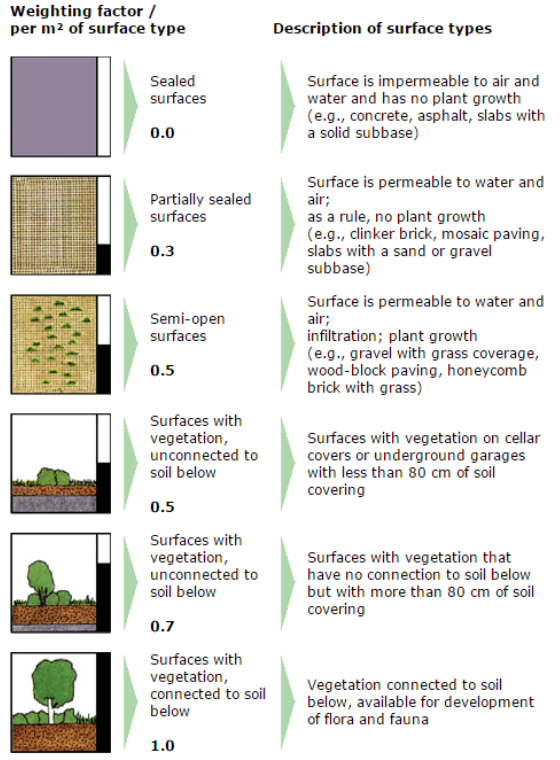
Figure 1. Excerpt from the original BAF look-up table